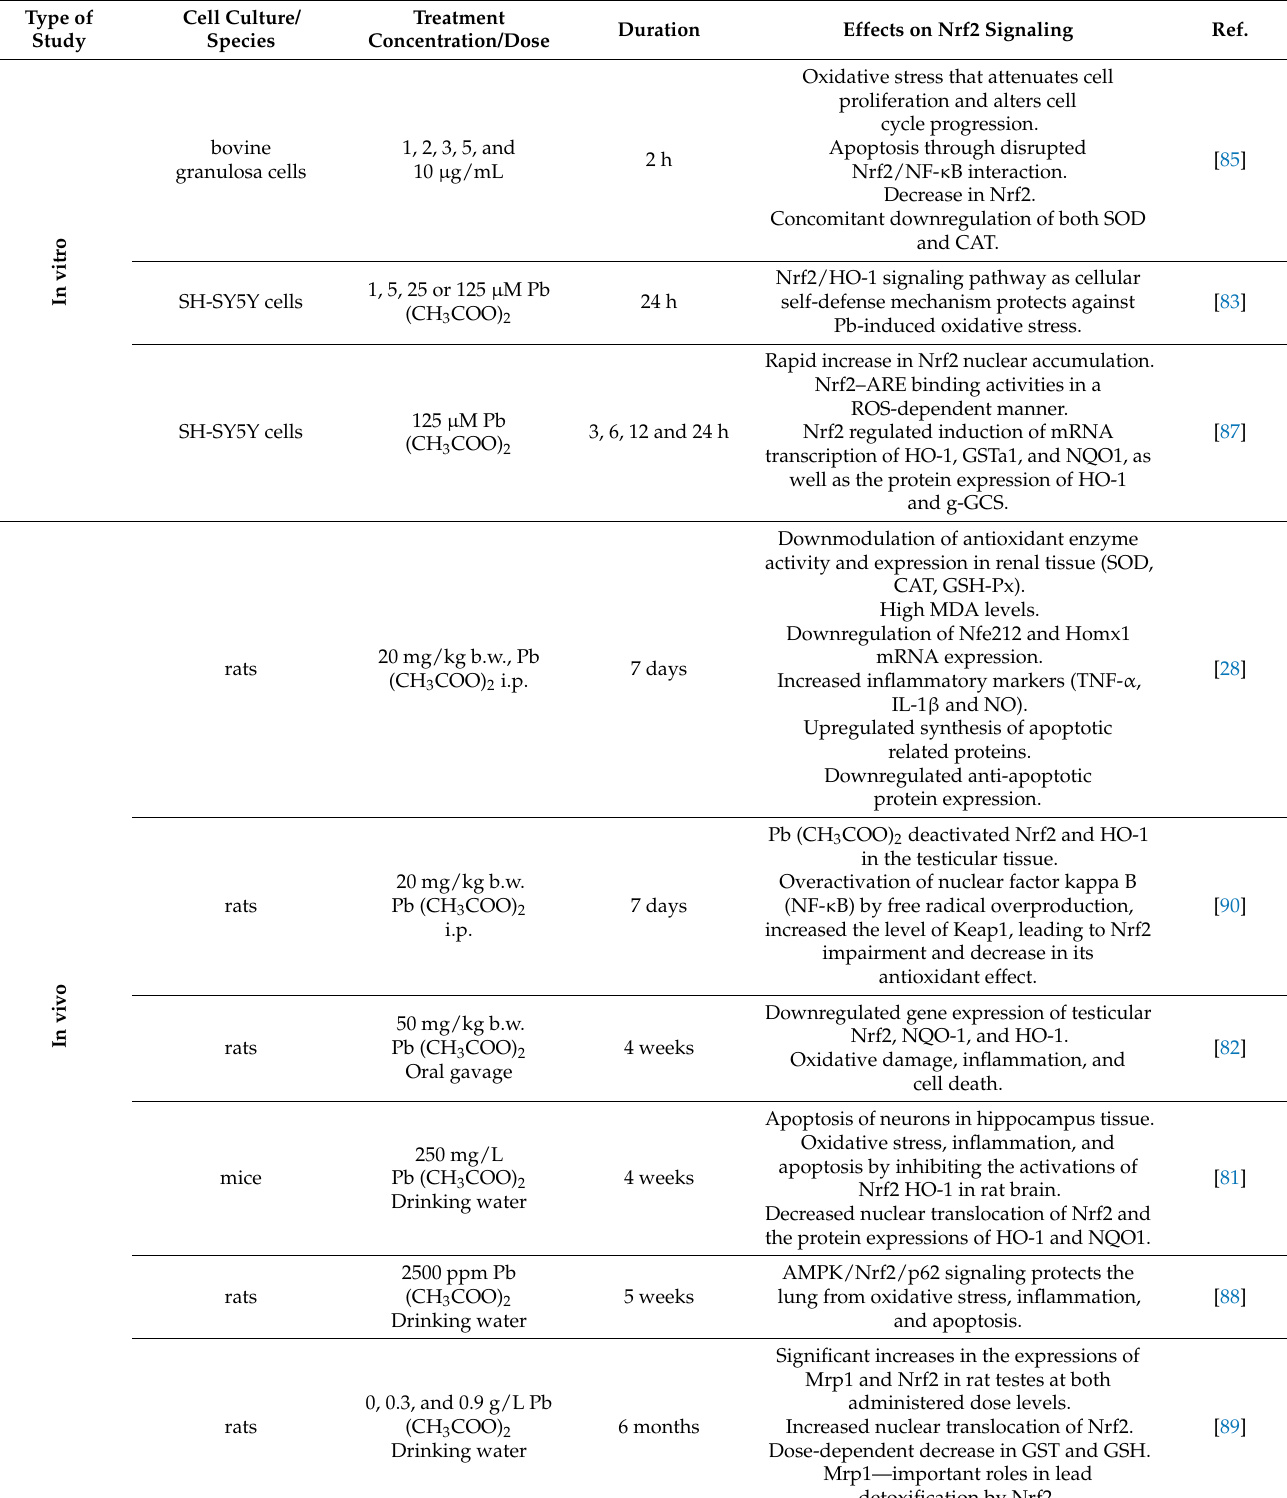
Table 2. Summary of studies analyzing the effects of Pb on Nrf2